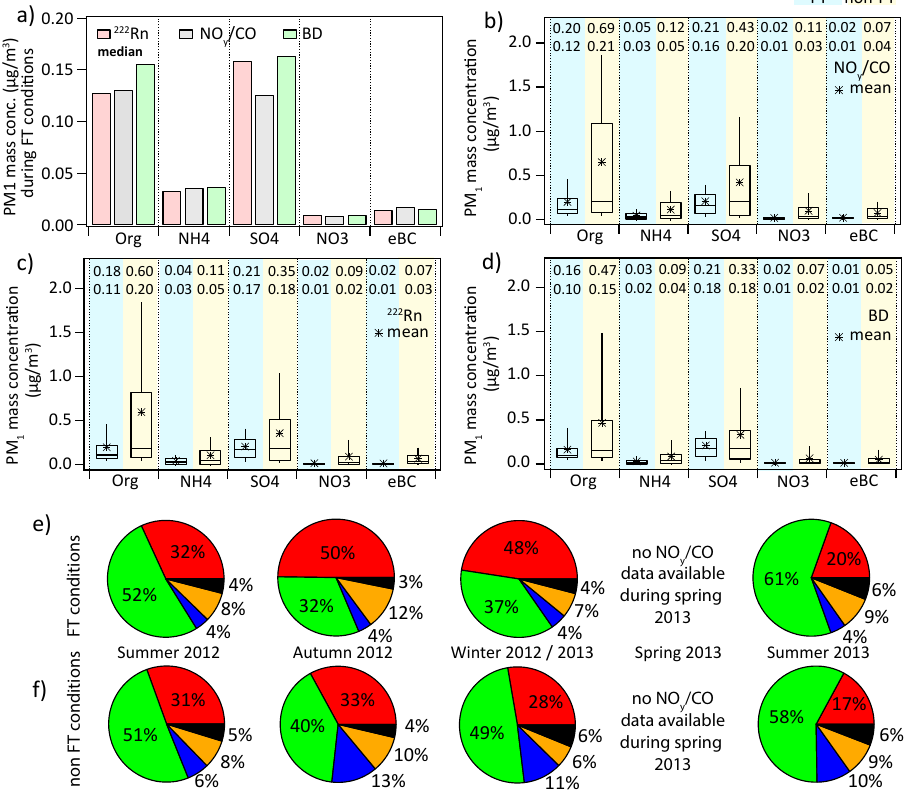
Figure 4. (a) Median NR-PM 1 species concentrations during free tropospheric conditions for three different criteria of FT separation: 222 Rn, NO y / CO and backward dispersion clustering. (b, d) Show mean (star) and median (horizontal bar) concentrations for each species measured by the ToF-ACSM during the periods with data for all three different criteria – (b) : NO y / CO, (c) 222 Rn, (d) BD clustering. Blue background: FT condition; yellow background: non-FT condition. Absolute mean (top) and median (bottom) values in µgm − 3 are given above each plot. The boxes represent the IQR and the whiskers the 10th to 90th percentile range. The pie charts show the relative species concentration of SO 2 − (red), NH + (orange), NO − (blue) and organics (green) for FT conditions (e) and for non-FT conditions (f) separated by seasons using 4 4 3 NO y / CO for FT discrimination. No NO y / CO ratios were available in spring 2013. 222 Rn data were not available after February